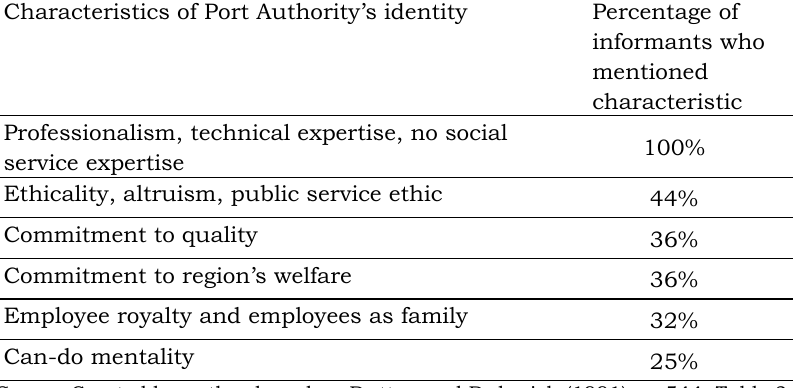
Table 1. Organizational identity of Port Authority Characteristics of Port Authority’s